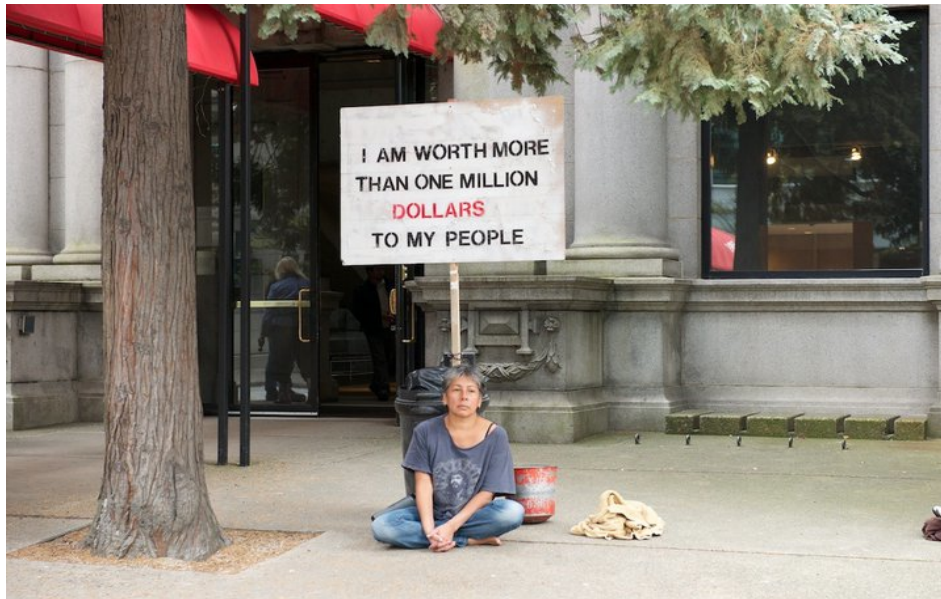
Rebecca Belmore, WORTH (A Statement of Defiance) , 2010. Performance still. Courtesy of Harold